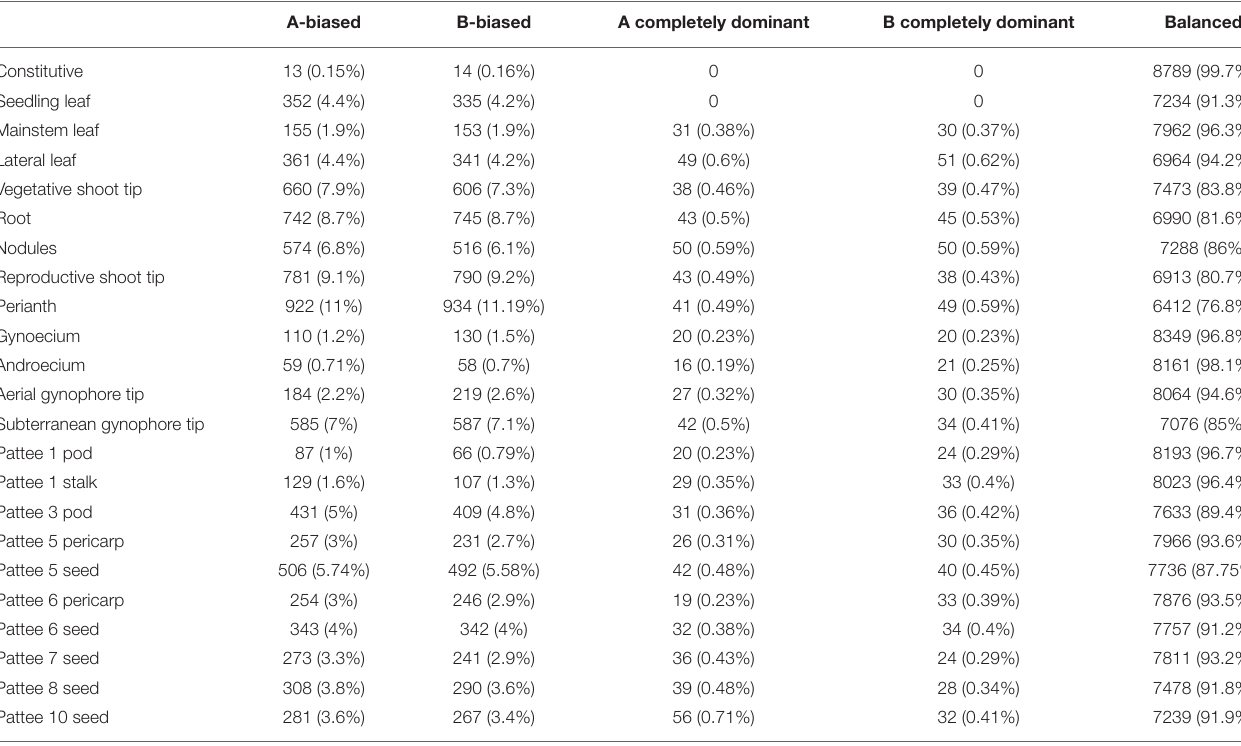
TABLE 2 | Genome-wide subgenome expression